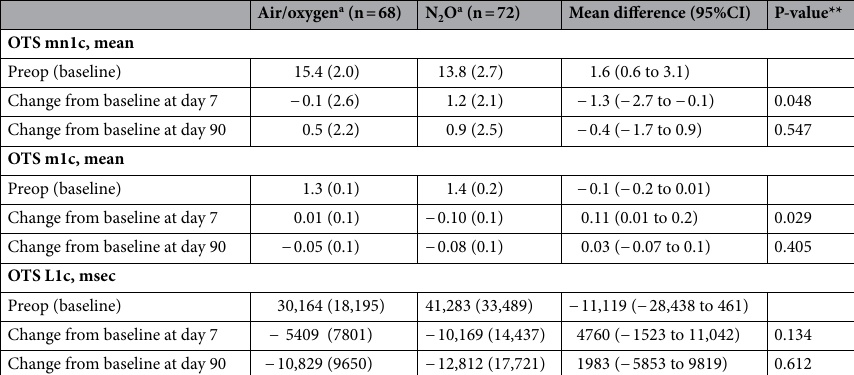
Table 5. Group differences for outcome measures of the one touch stocking test (OTS). OTS N1C, Mean Number first choice or the mean of the total number of problems out of 20 solved on first choice; OTS M1C, Mean first choice or the total mean number of unique box choices made on each of the 6 problems to find correct solution; OTS L1C, Latency first choice or the mean latency time between ball appearance and screen touch for unique box choices made on each of the 6 problems to find correct solution. **Change from baseline was compared between trial groups with t tests. In addition, a modification of the effect from day 7 to day 90 was tested with an interaction term in a linear regression model with mixed effects and was not found statistically significant (p-values from 0.12 to 0.46). a All data are presented as mean (±